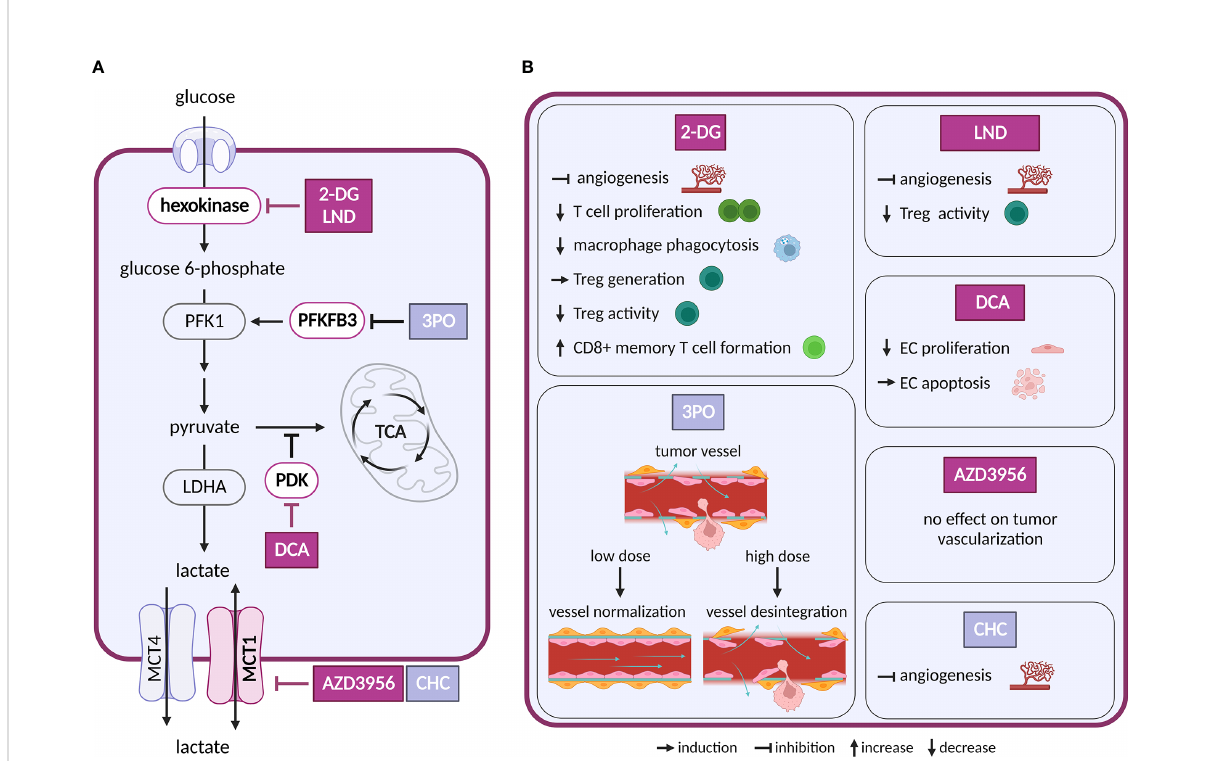
FIGURE 2 Inhibitors of glycolysis and their effect on TME cell types. (A) Schematic representation of glycolysis and lactate exchange. Only inhibitors with a reported effect in the TME are shown. Inhibitors tested in clinical trials for cancer are highlighted in dark violet, inhibitors tested in preclinical studies are shown in light grey-blue (B) Effects of the inhibitors shown in (A) on cell populations in the